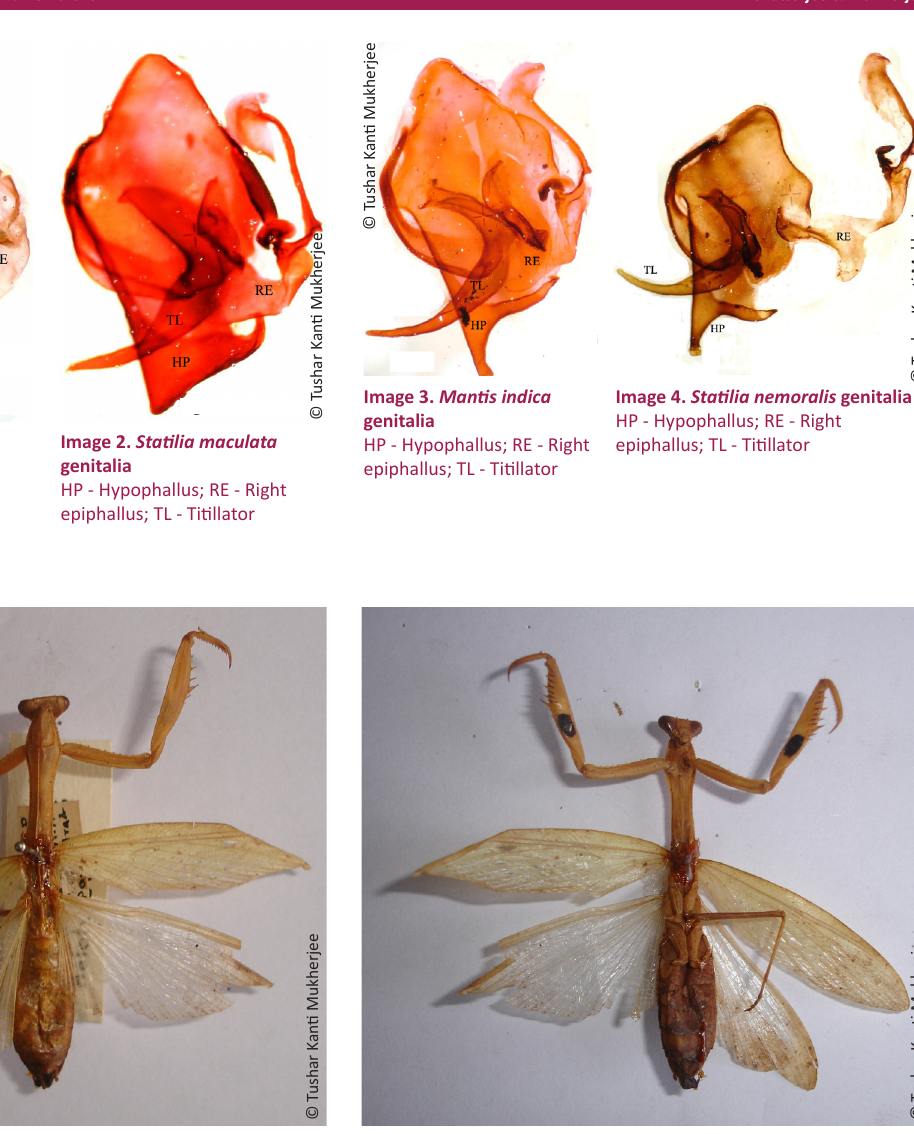
Image 5. Mantis indica (holotype female), dorsal view Image 6. Mantis indica (holotype female), ventral